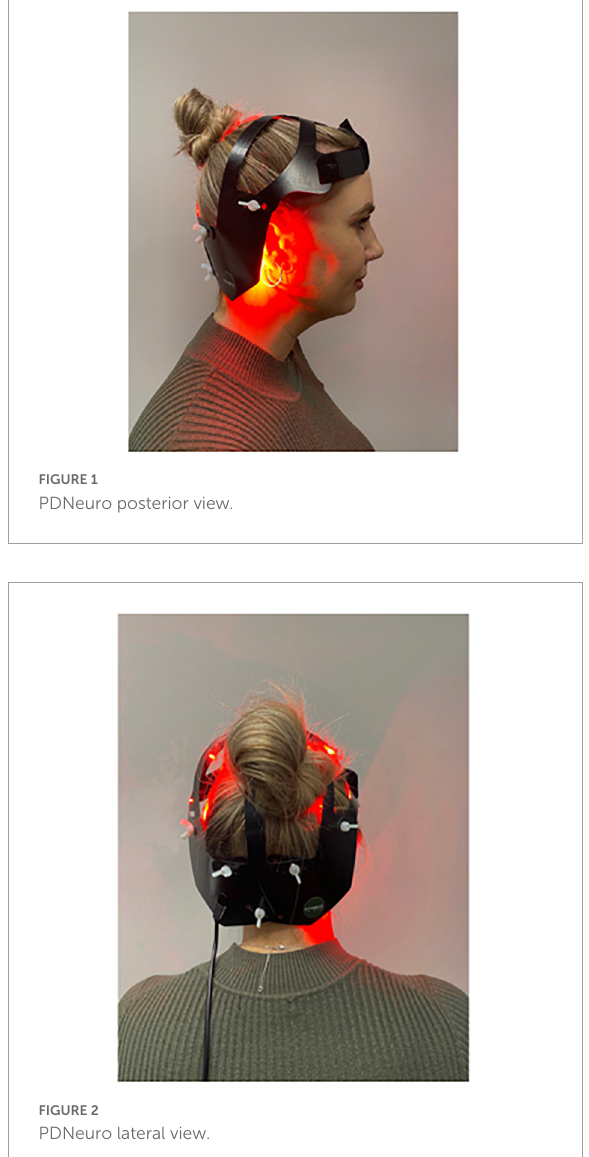
FIGURE2 PDNeuro lateral